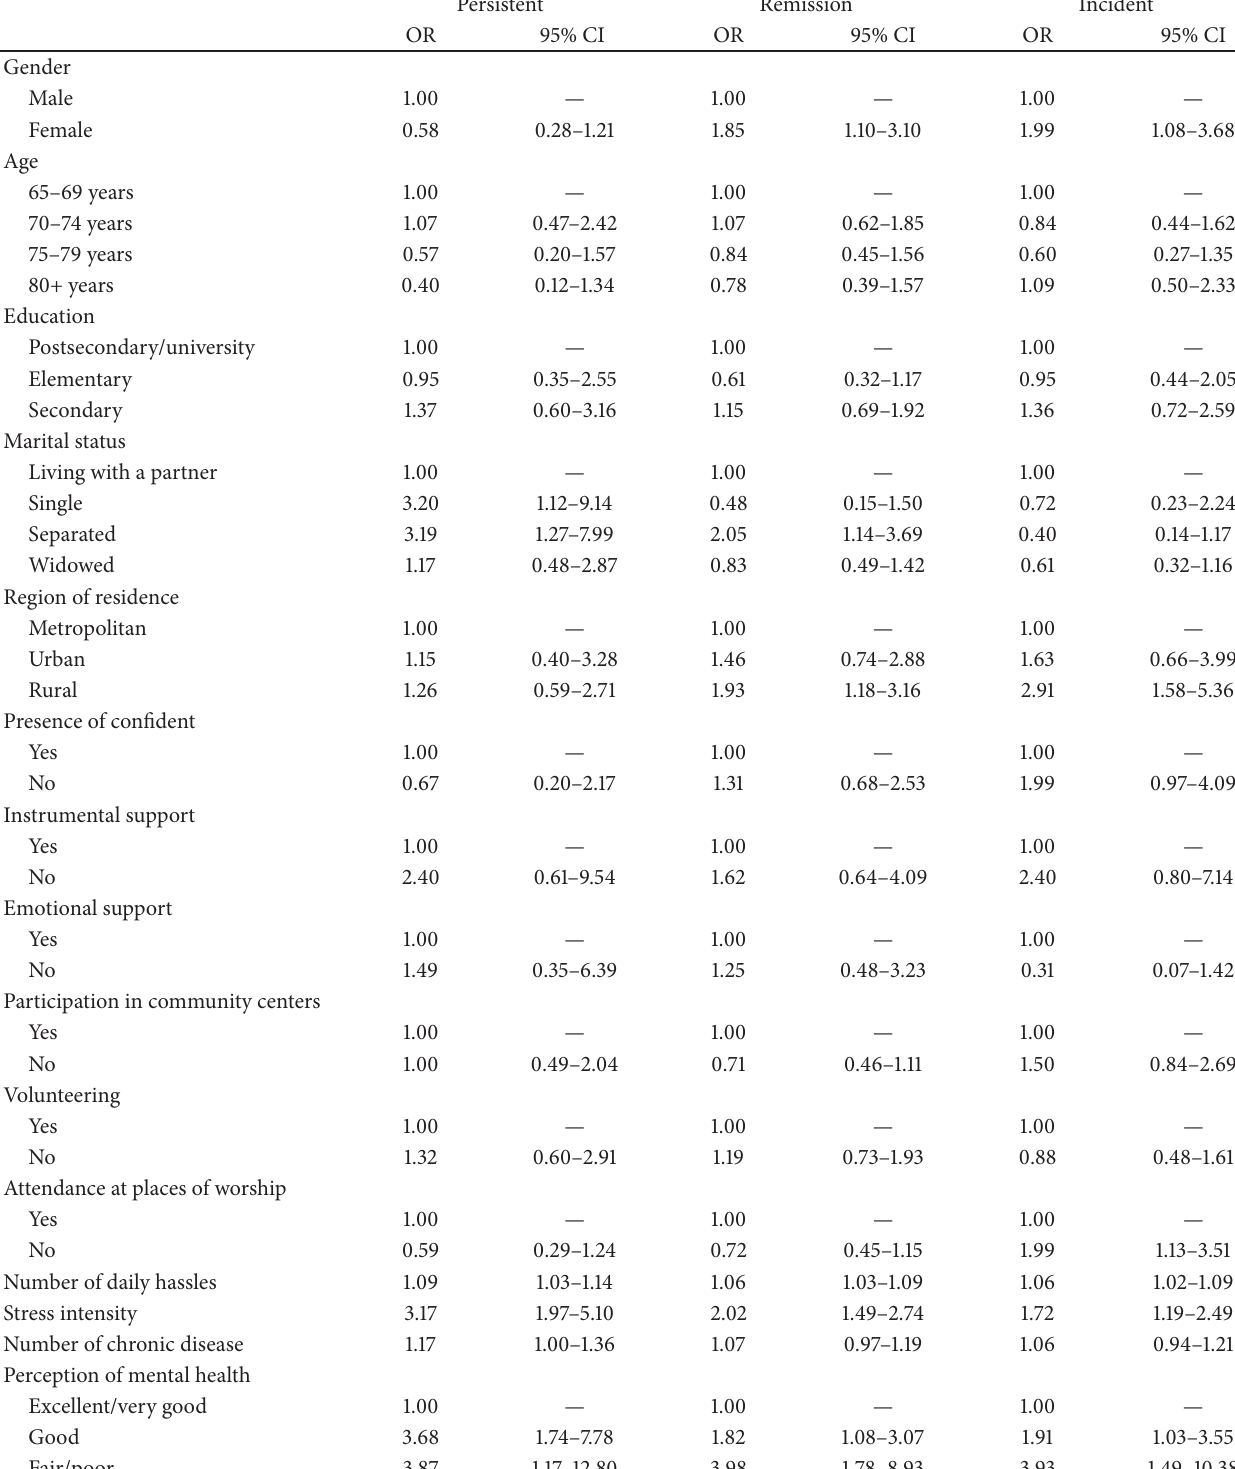
Table 1: Multivariate polytomous regression models predicting depression’ outcomes at time